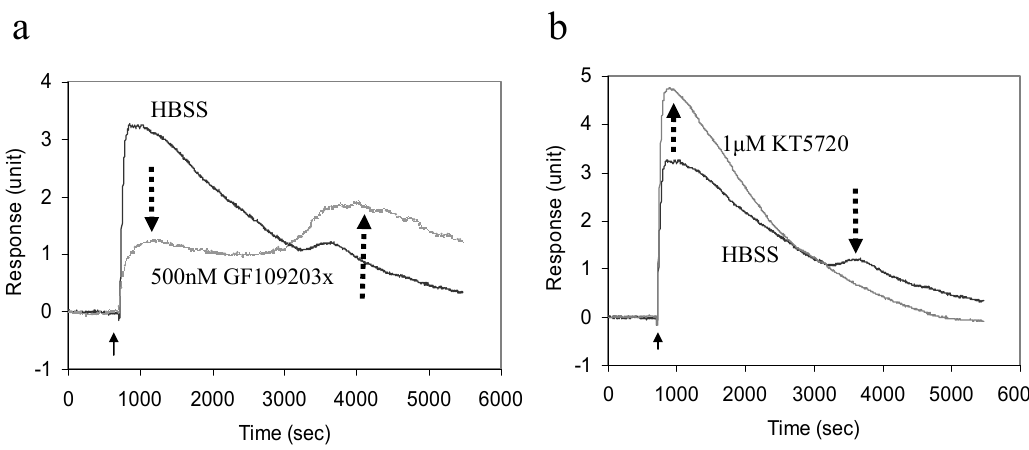
receptor in A431 cells. Figure 5. Chemical intervention reveals dual signaling of bradykinin B 2 The bradykinin-induced DMR responses of cells pre-treated with the buffer only (HBSS) were in comparison with those pretreated with 500nM GF109203x (a protein kinase C inhibitor) (a), or 1 μ M KT5720 (a protein kinase B inhibitor) (b). The bradykinin concentration was 16nM, and the cells were starved with 0.1% fetal bovine serum medium for 18hrs before assays. The solid arrows indicate the time when the agonist solution is introduced. Data was reproduced with permission from ref. 10